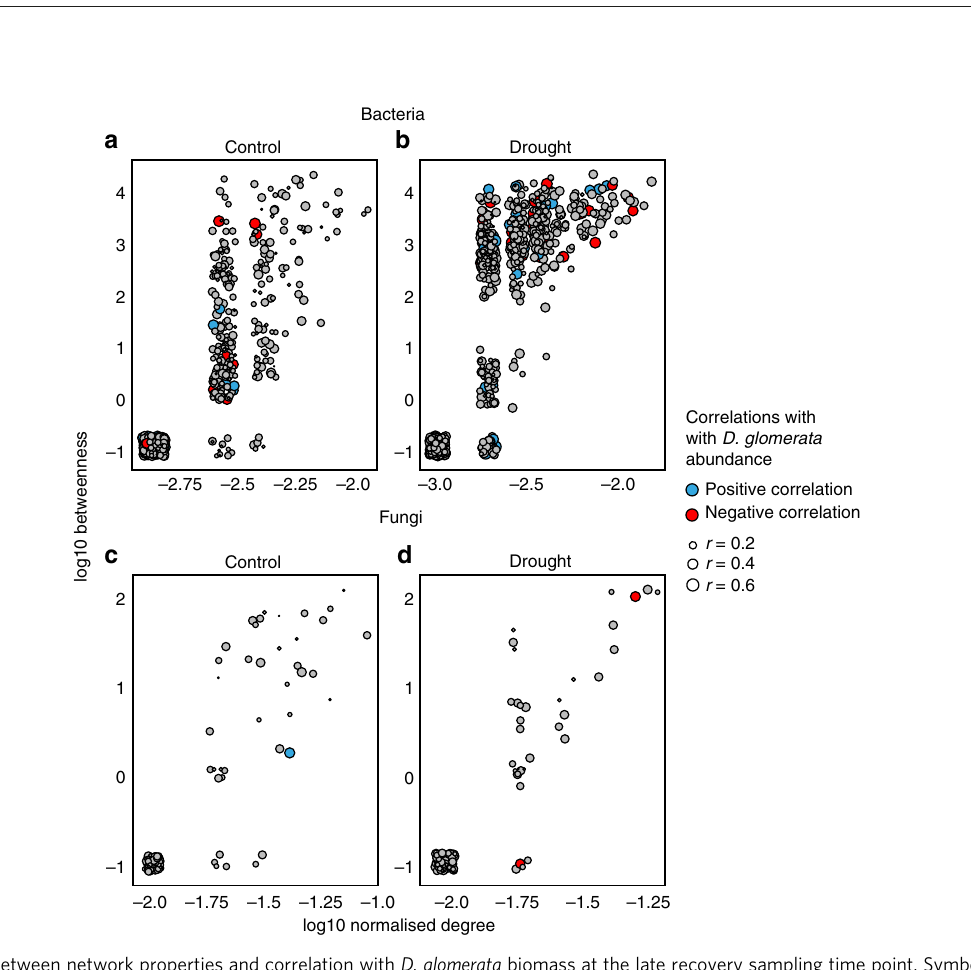
Fig. 6 Drought effects on plant community composition and the relationship between changes in plant community composition and microbial community composition. Biomass of the four species in our established plant communities in the pre-drought season ( a ), just before drought ( b ) and 2 months after ending the drought ( c , d ), split for control ( c ) and drought communities ( d ). Plant community treatments are on the x -axis, with three different evenness levels and each species dominating within each evenness level. Total community biomass increased marginally in response to drought (ANOVA F 1,48 = 273, P = 0.08); D. glomerata (Dg) biomass increased strongly under drought, except in Anthoxanthum odoratum (Ao)-dominated communities (ANOVA dominant species × Drought interaction F 14,48 = 4.52, P = 0.004). Ao Anthoxanthum odoratum , Dg Dactylis glomerata , Lh Leontodon hispidus , Ra Rumex acetosa . PCA-biplot of plant community composition ( e ) shows that PC-axes 1 and 2 scores were signi fi cantly affected by drought at the late recovery